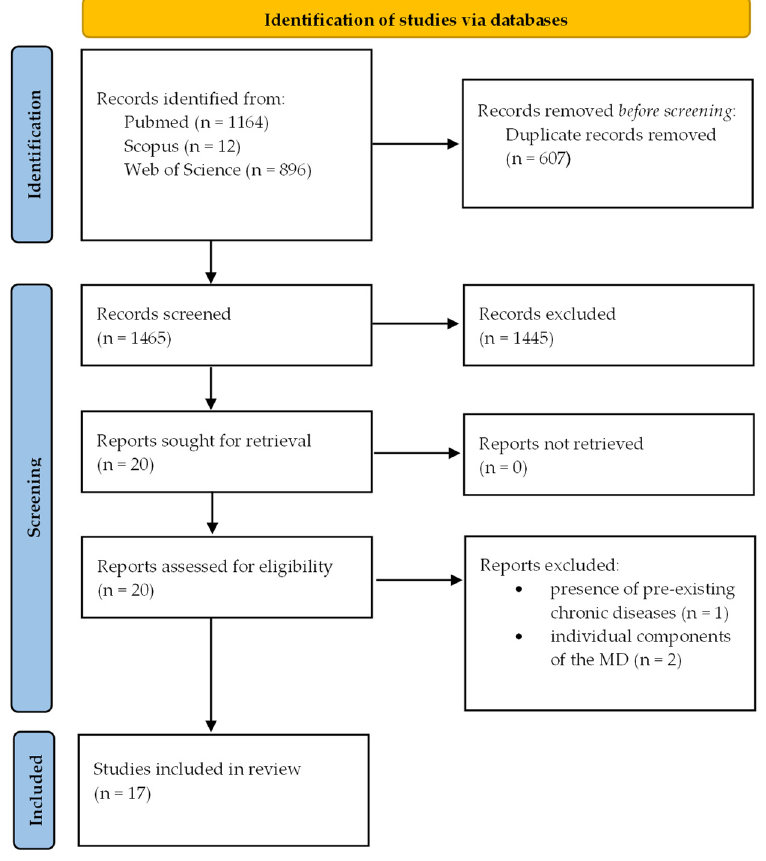
Figure 1. Flow diagram of the study selection process.